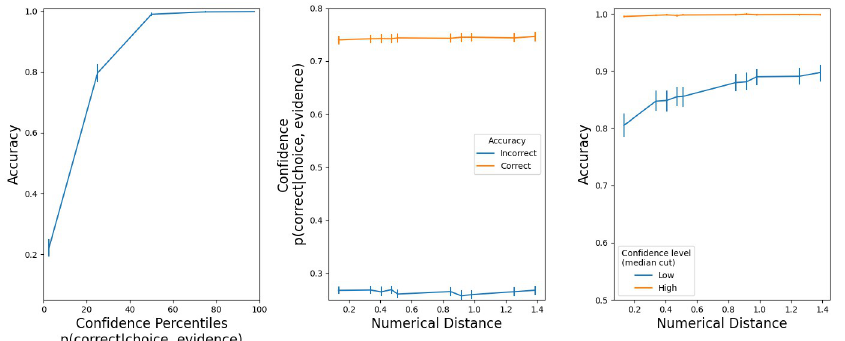
Fig 4. Confidence properties in the drift diffusion model (Exp 1). Left panels: accuracy increased with more confidence. Center panels: there was low confidence in incorrect trials. Right panels: accuracy is higher in high confidence trials. Error bars are s.e.m.